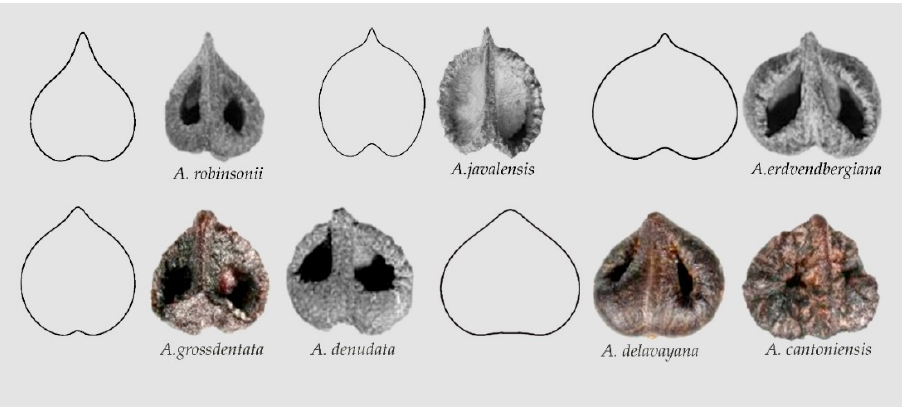
Figure 6. Models of broadened heart curves and seeds resembling each of them in Ampelocissus and Ampelopsis . ( Top ): Model ARO1, Ampelocissus robinsonii , Model AJA1, Ampelocissus javalensis , Model AER1, A. erdvendbergiana . ( Bottom ): Model AGR1, Ampelopsis grossedentata , A. denudata ; Model ADE1, A. delavayana , A. cantoniensis .